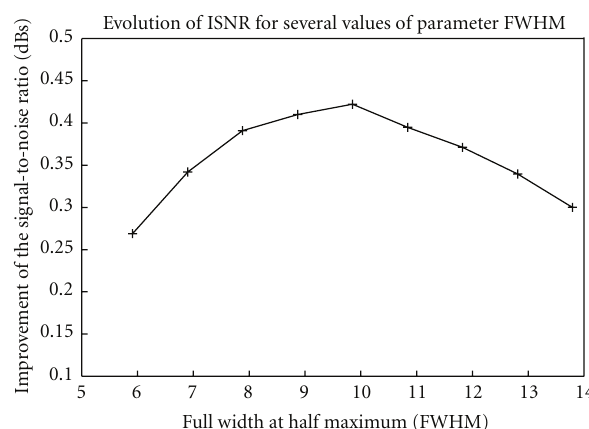
Figure 4: ISNR as a function of the parameter FWHM for the Ho ff man phantom